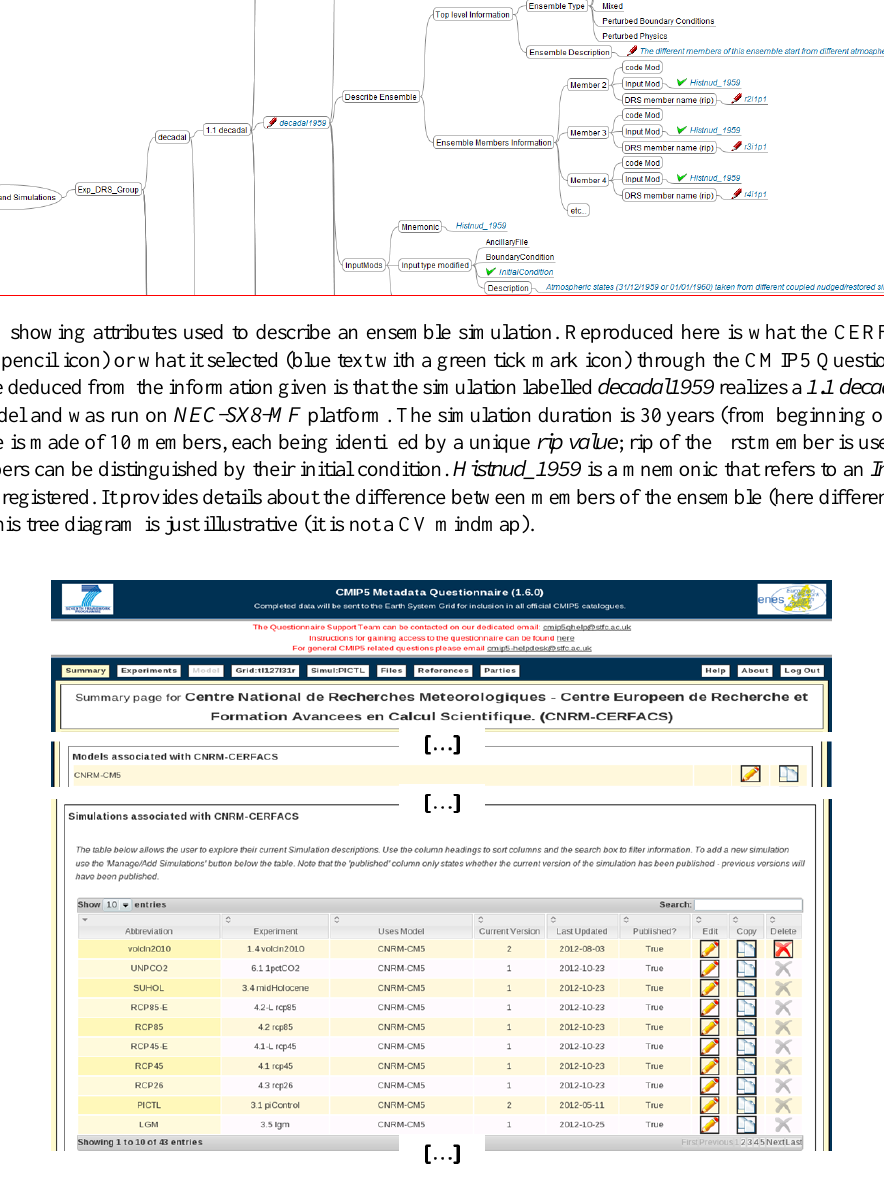
Fig. 6. Partial view of the CMIP5 Questionnaire summary page for CNRM-CERFACS modelling group and its CNRM-CM5 coupled model (Voldoire et al., 2011)